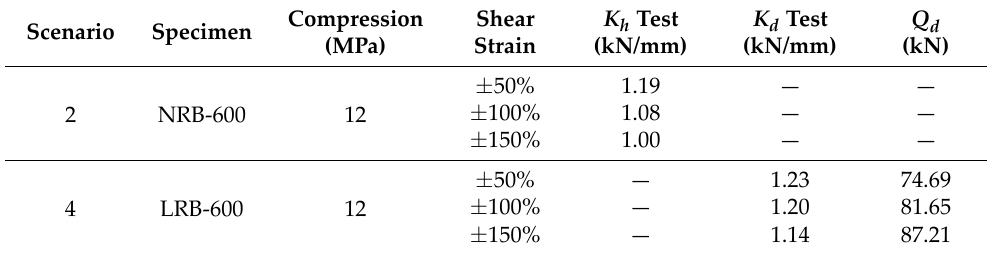
Table 5. Mechanical properties of the specimen obtained in the horizontal shear tests.